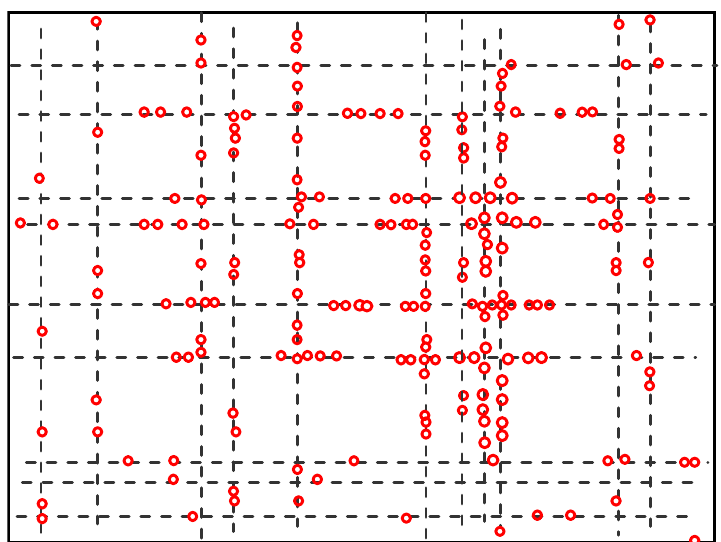
Figure 4. Node distributions at 8